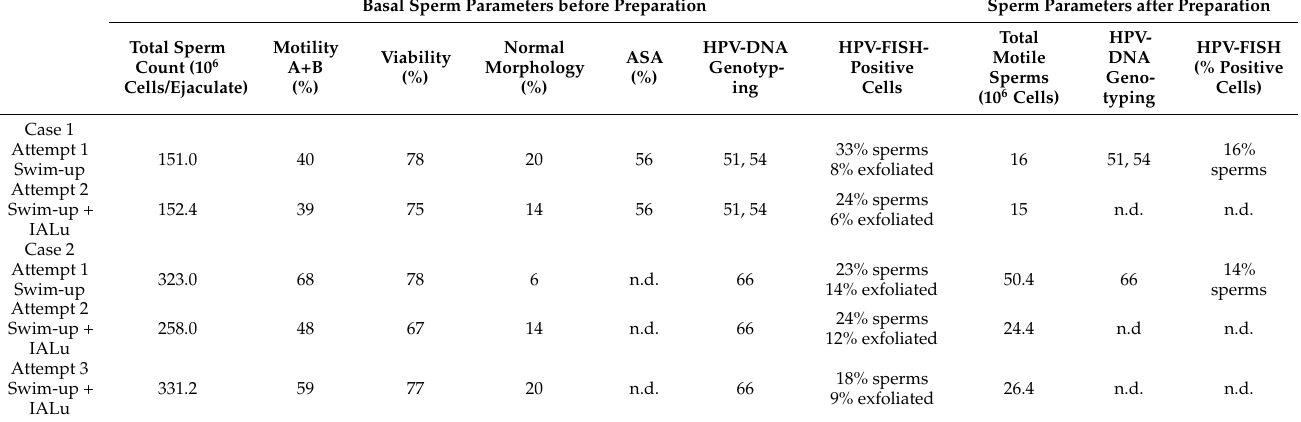
Table 1. Sperm parameters and details of human papillomavirus DNA detection in the male subjects at both basal conditions before semen preparation and upon sperm preparation by swim-up or IALu